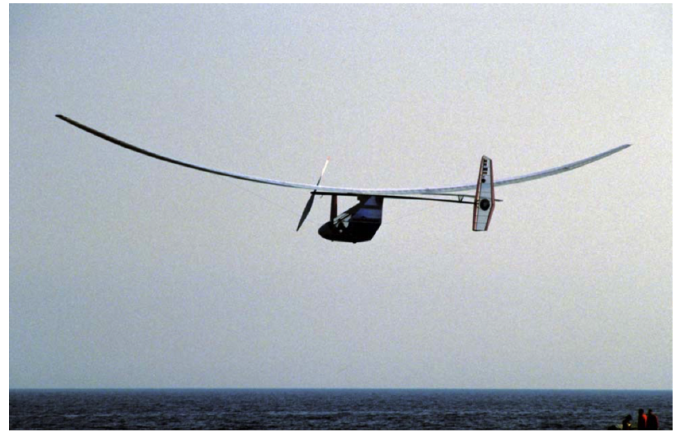
Figure 1. The Daedalus.